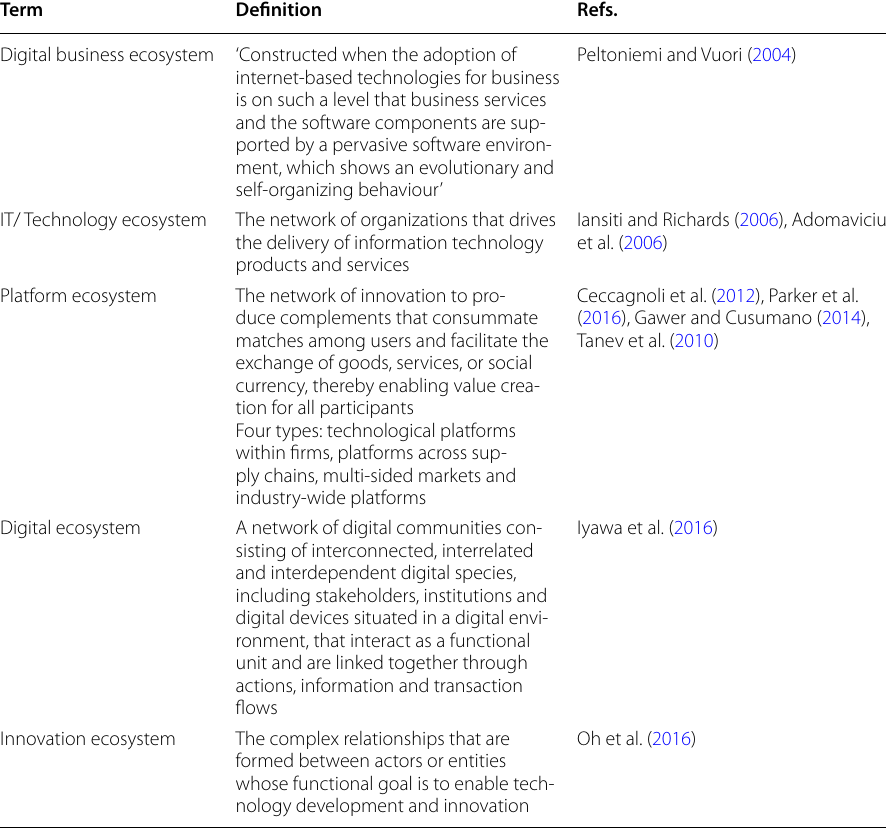
Table 4 Definitions of various ecosystem analogies Term Definition